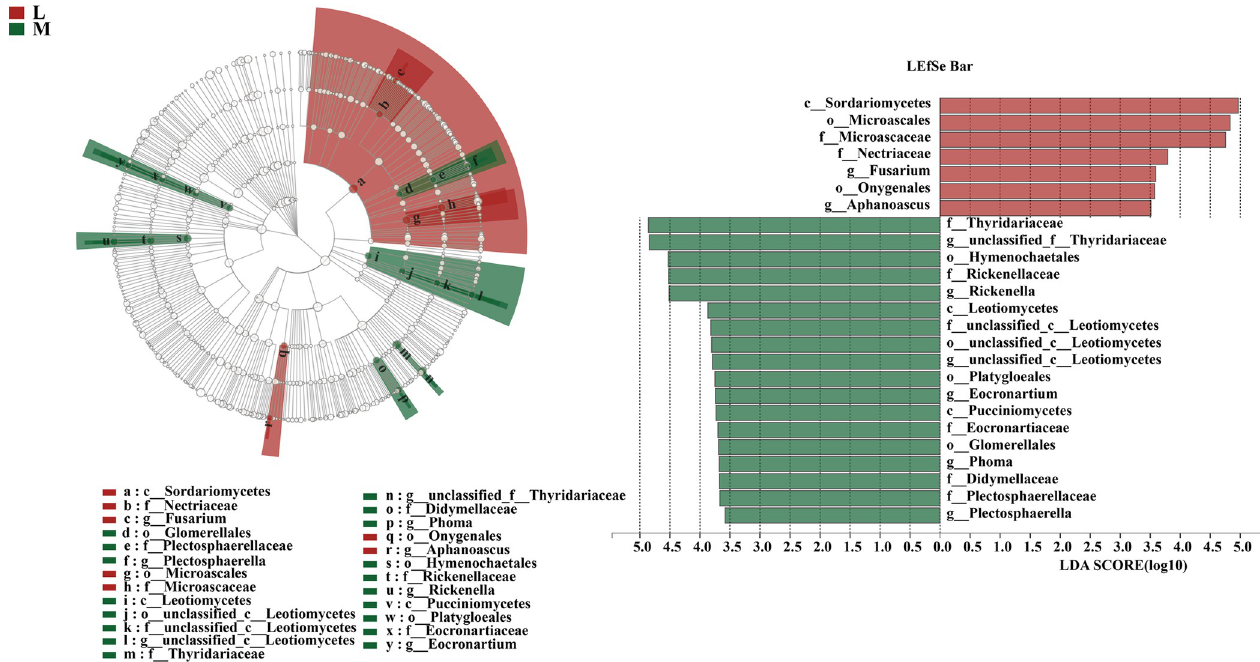
Fig 15. LEfSE analysis of significant marker groups of soil fungal communities between moss- (M) and non-moss growth(L) areas in litchi orchard.